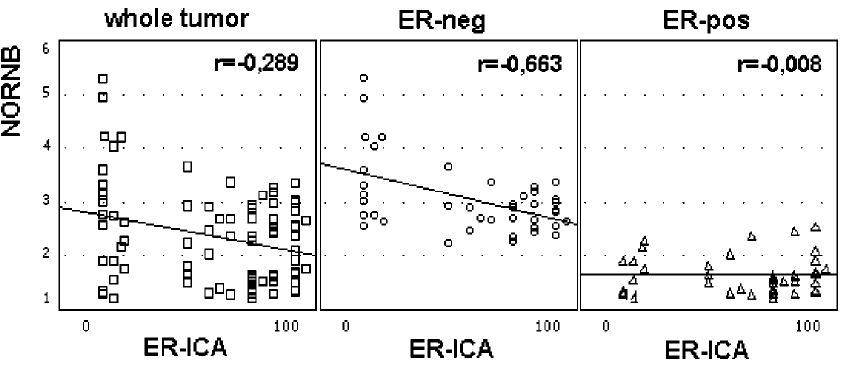
Fig. 4. Correlation between AgNOR number per nucleus (NORNB) and Estrogen-Receptor-Immuno-Cytochemical-Assay (ER-ICA) [%] plotted for the whole tumor (left), ER-negative cells (middle) and ER-positive cells (right).